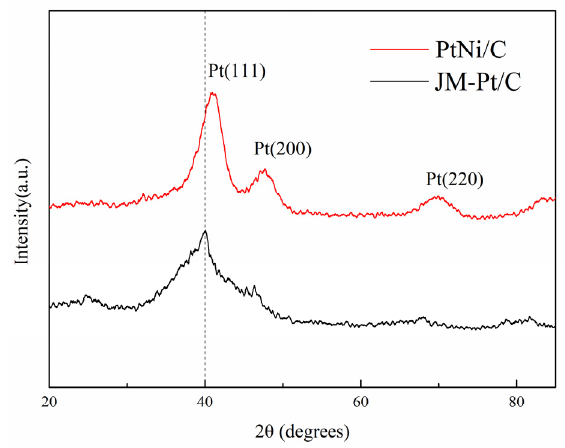
Figure 2. XRD patterns of PtNi/C and JM-Pt/C.